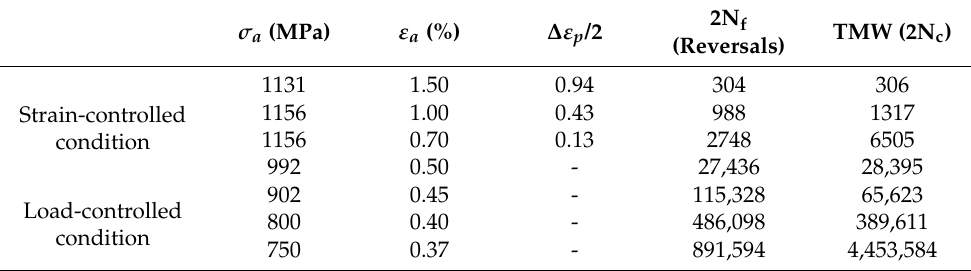
Table 3. Fatigue test results of H1025 heat-treated wrought 17-4 PH stainless steel with the machined surface under axial loading (test information and data taken from [13]).